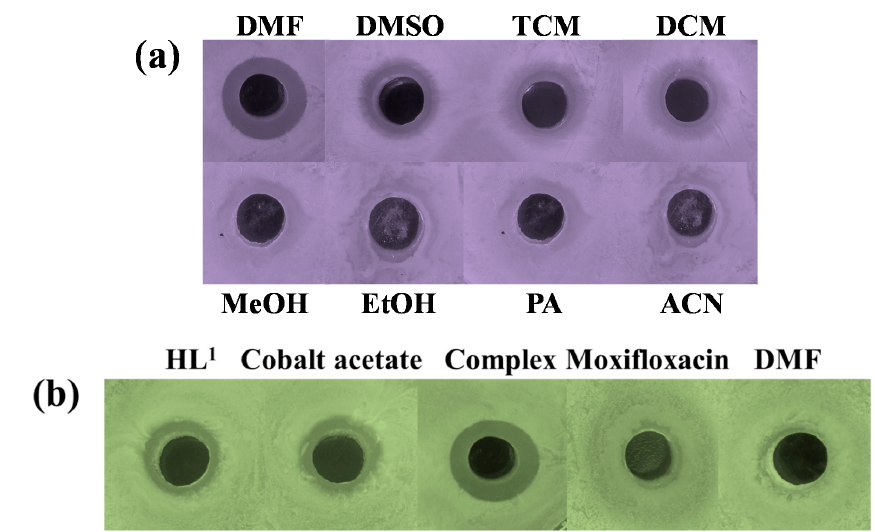
Figure 9. ( a ) The diameter of the inhibition zone of Escherichia coli in different solvents of the Co(II) complex; ( b ) The diameter of the inhibition zone of Escherichia coli in different samples at a concentration of 3.2 mg/mL.